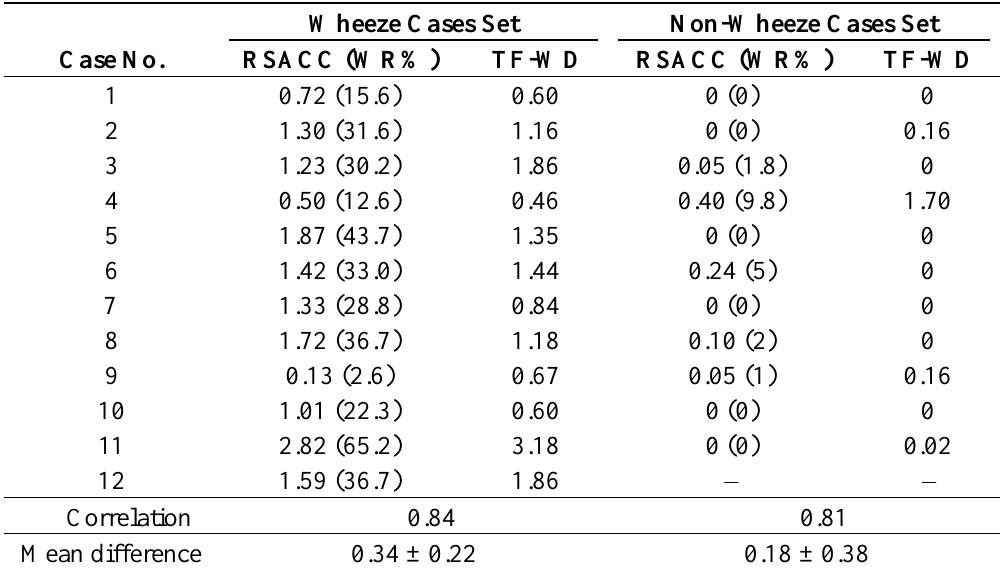
Table 2. The comparison of WS durations (seconds) of RSACC and TF-WD. Wheeze Cases Set Non-Wheeze Cases